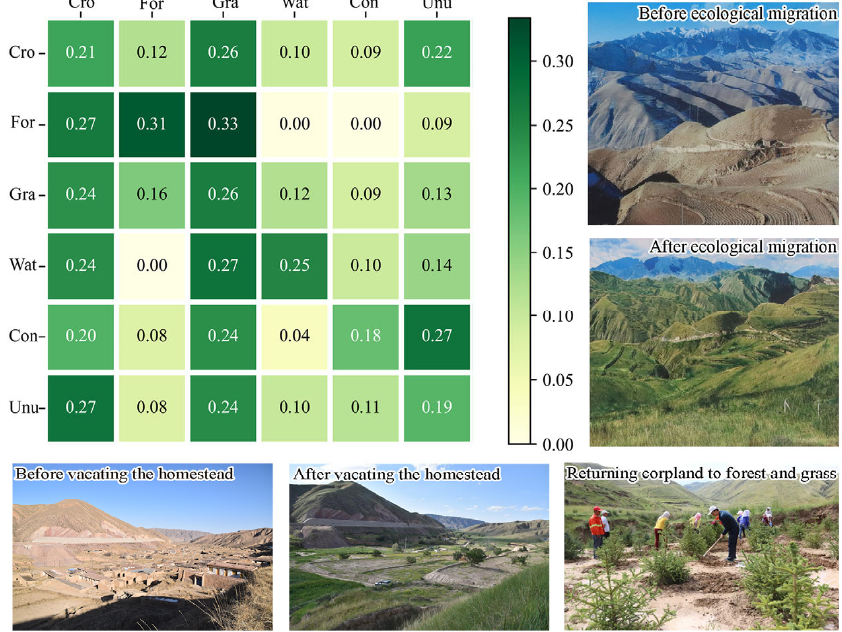
Figure 10. Contribution of land use transfer to CNL and ecological restoration before and after ecological migration. The abbreviations of land use types in the map are as follows: Cro, cropland; For, forest; Gra, grassland; Wat, water; Con, construction land; Unu, unused land (Photographs of the current situation provided by local